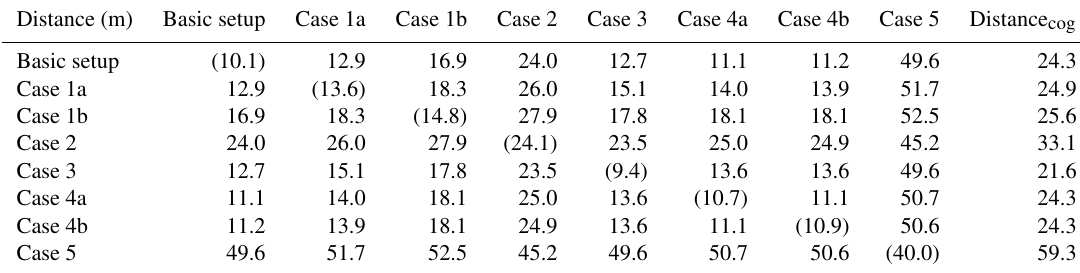
Table 3. A summary table showing the average distance value for each 50 by 50 square representing a given case in the distance matrix (Fig. 11a). The final column, labeled Distance cog , summarizes the distances to the cognitive geological model, presented as the average of each colored point cloud in Fig. 11b. The distances in parenthesis represent ensemble variabilities, and the remaining values represent average distances between different ensembles. The unit of the average distances is